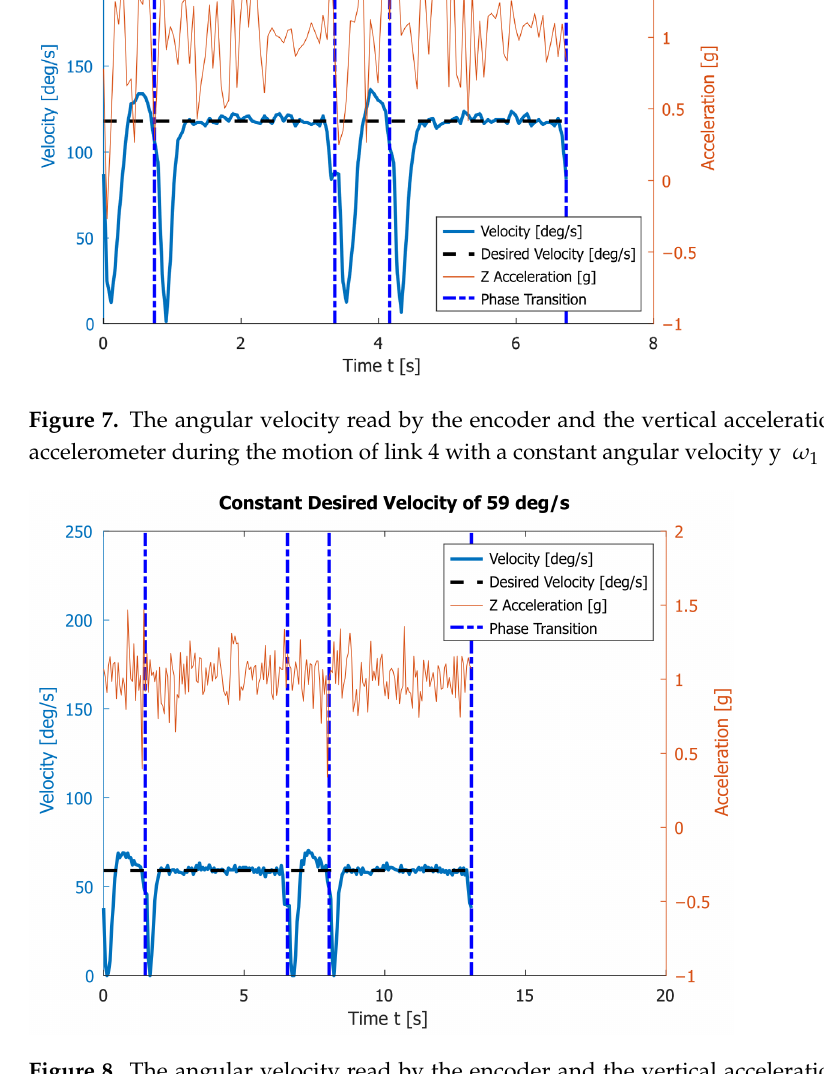
. accelerometer during the motion of link 4 with a constant angular velocity ω = 59 [ ◦ / s ] 2 𝜔𝜔 2 = 59[° 𝑠𝑠⁄ ]